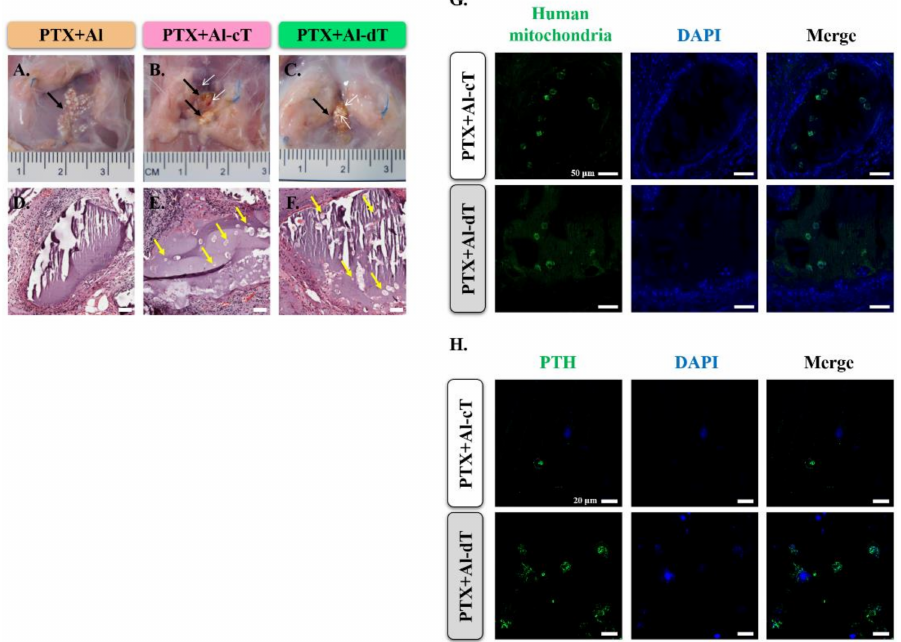
Figure 7. Detection of implanted TMSCs with alginate microbeads. ( A – C ) At 12 weeks after implan- tation, alginate microbeads, indicated by black arrows, were detected in the PTX animal model. The white arrows indicate the formation of the blood vessels. ( D – F ) Histological evaluation of implanted alginate microbeads. TMSCs were identified in PTX+Al-cT and PTX+Al-dT (yellow arrows). Scale bar = 50 µ m. ( G ) The presence of TMSCs inside alginate microbeads was confirmed by immunofluo- rescence analysis using human mitochondria antibody (green). Scale bar = 50 µ m. ( H ) The expression of PTH in implanted alginate microbeads. Immunofluorescence analysis revealed that the expression of PTH (green) was more extensive in PTX+Al-dT compared to that in PTX+Al-cT. Scale bar = 20 µ